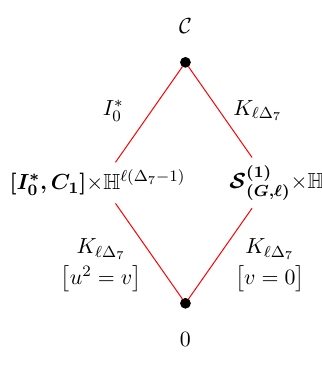
Figure 3. Special K(cid:127)ahler strati(cid:12)cation for S (2)